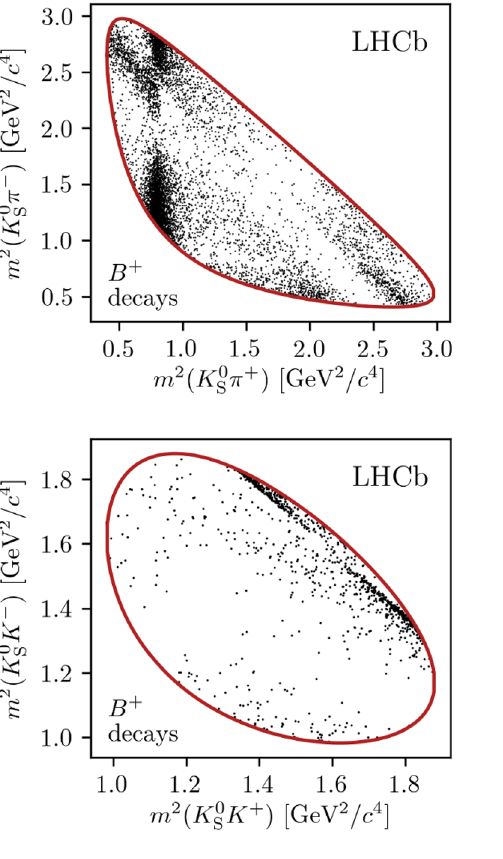
Figure 2 . Dalitz plot for D decays of (left) B + → DK + and (right) B − → DK − candidates in the signal region, in the (top) D → K 0 π + π − and (bottom) D → K 0 K + K − channels. The horizontal S S and vertical axes are interchanged between the B + and B − decay plots to aid visualisation of the CP asymmetries between the two